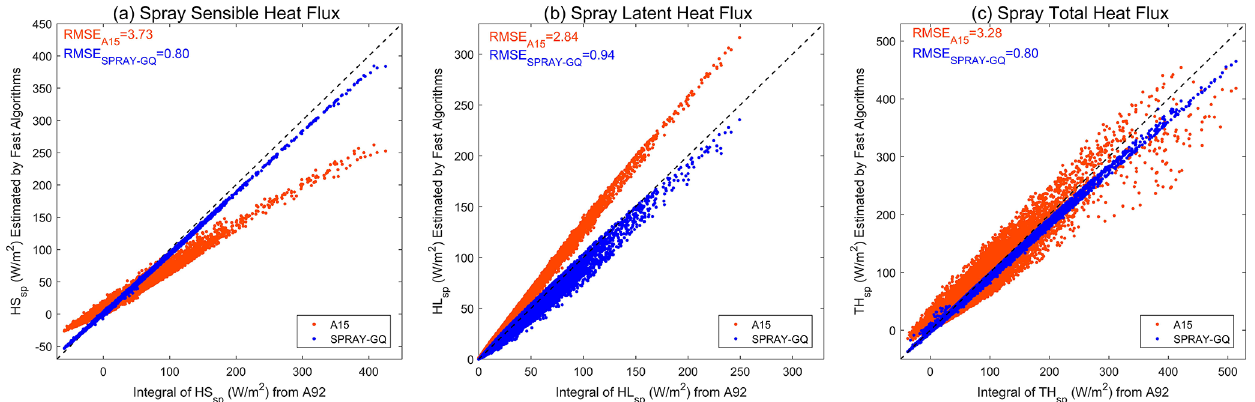
Figure 4. The same as Fig. 3, but WSP10, 2m air temperature and 2m specific humidity of OAFlux are used.